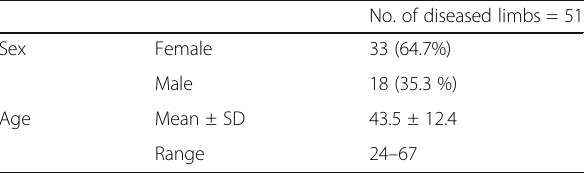
Table 1 Demographic data of the study population